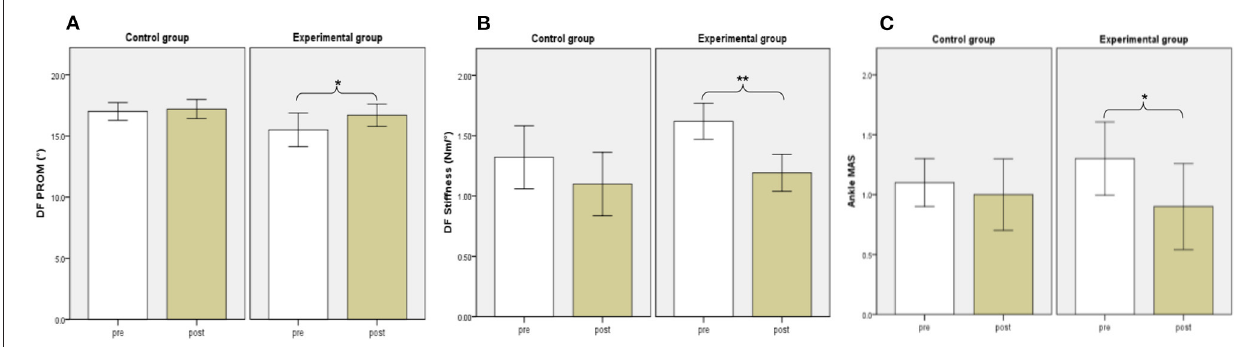
FIGURE 4 | Biomechanical and Clinical evaluations between groups. DF PROM (A) , DF Stiffness (B) , Ankle MAS (C) . White and brown bars indicate pre-, and post-assessment. Error bars indicate standard error of the corresponding average (* p < 0.05 and ** P < 0.01). DF, dorsiflexion; PROM, positive range of motion; MAS, Modified Ashworth